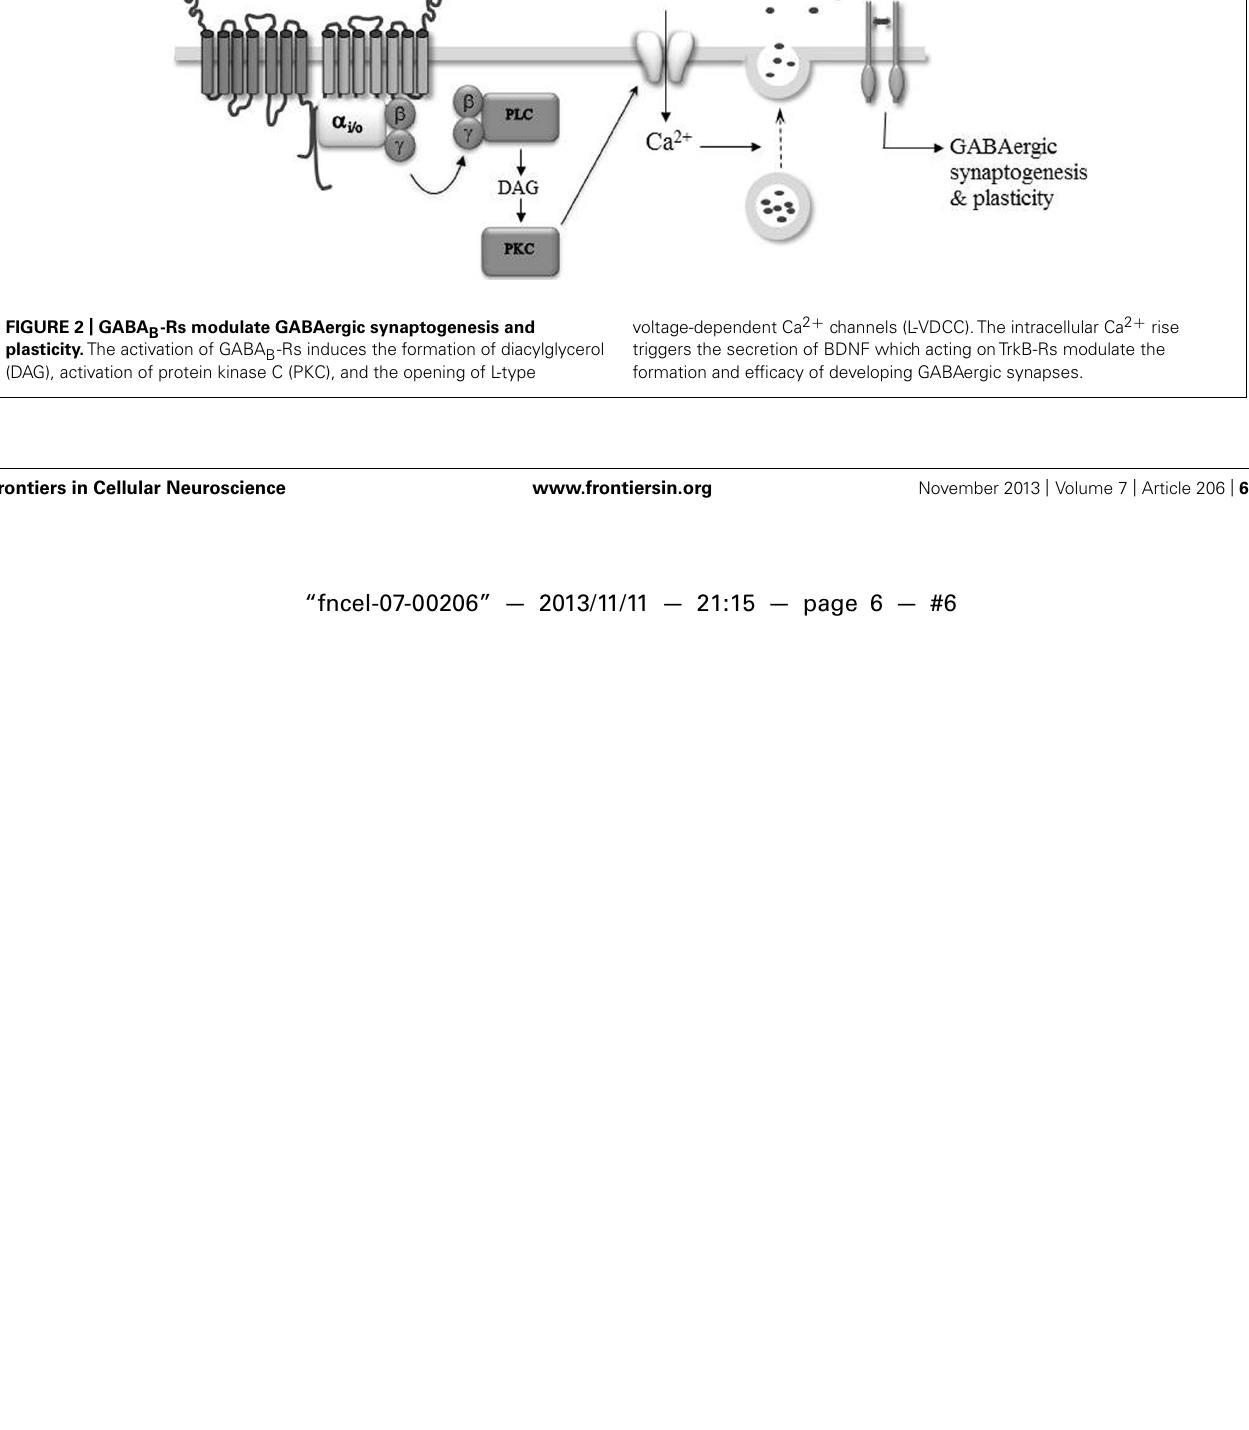
FIGURE 2 | GABA B -Rs modulate GABAergic synaptogenesis and plasticity. The activation of GABA B -Rs induces the formation of diacylglycerol (DAG), activation of protein kinase C (PKC), and the opening of L-type